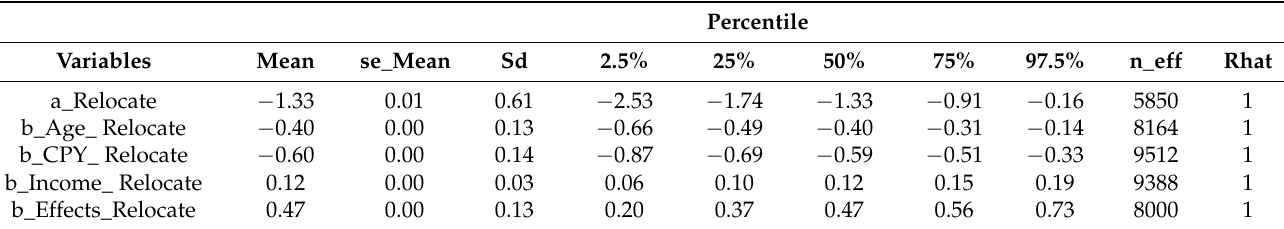
Table 5. Estimated results of relocating intention